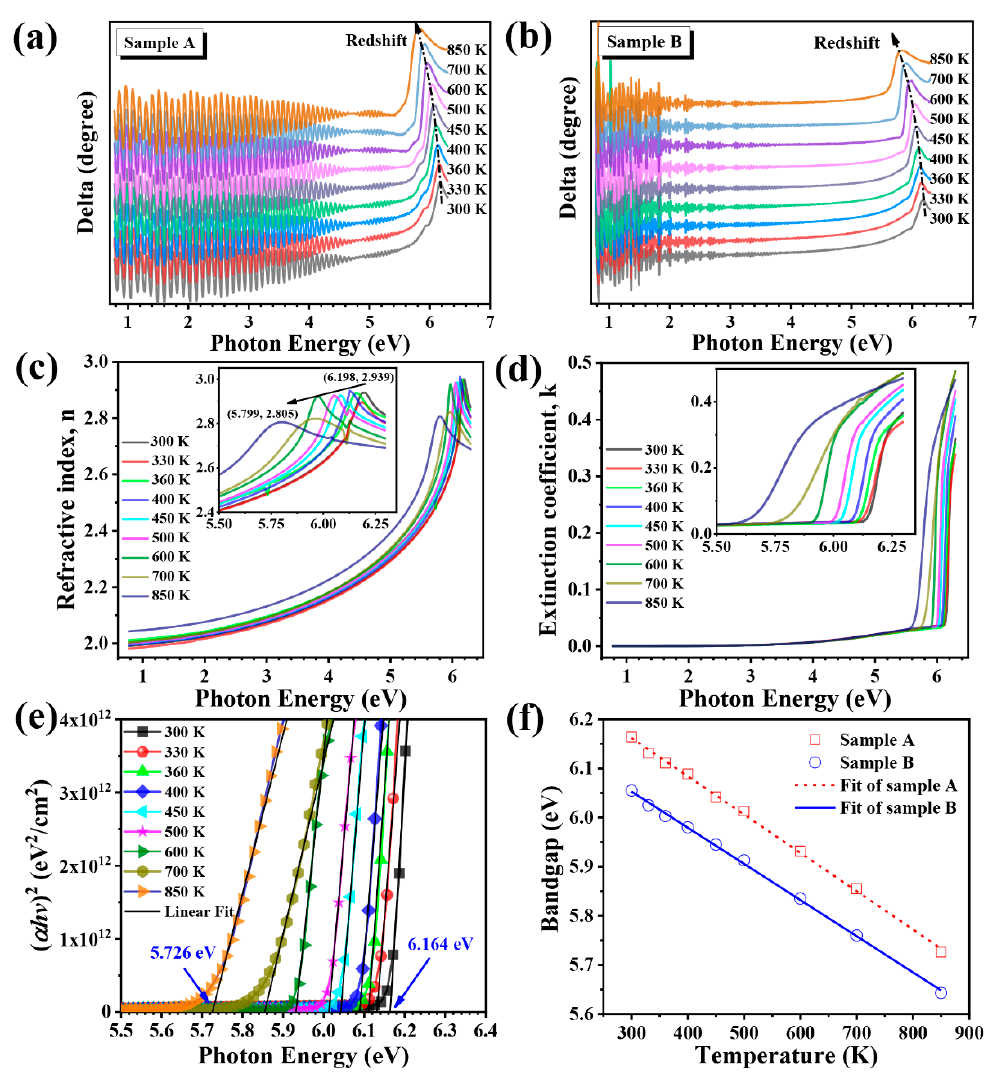
Figure 9. The experimental data of the delta ( Δ ) graph with the incident angle of 70° in the temperature range of 300 K to 850 K: ( a ) sample A and ( b ) sample B. Fitted optical constants ( c ) refractive index and ( d ) extinction coefficients of sample A with temperature varied from 300 K to 850 K. ( e ) The square of the absorption coefficient ( α h υ ) 2 vs. photon energy ( h υ ) for sample A at 300–850 K. ( f ) The variation of bandgap ( E g ) vs. temperature (T) of sample A fitted by the Varshni empirical equation in the range 300–850 K.